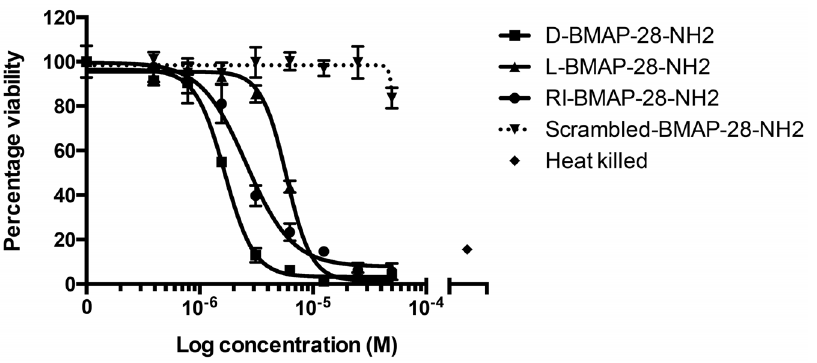
Fig. 4. Promastigote viability assay of Leishmania major when treated with amidated BMAP-28 variants. L. major MHOM/SN/74/SD strain was treated with L-, RI- and D-BMAP-28 peptides for 4 hours. Viability was expressed as a percentage of untreated control cells. Three complete biological replicates were performed and the standard errors are